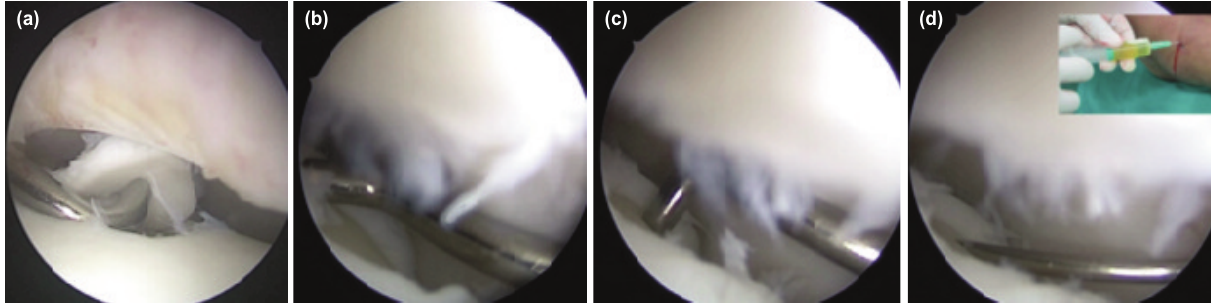
Shows arthroscopic procedure; (a) loose cartilage flap, (b) subchondral area of bone after debridement, (c) microfracture, Fig. 2: (d) PRGF-Endoret® injection into the holes of microfracture with needle inserted in one of the holes under arthroscopy